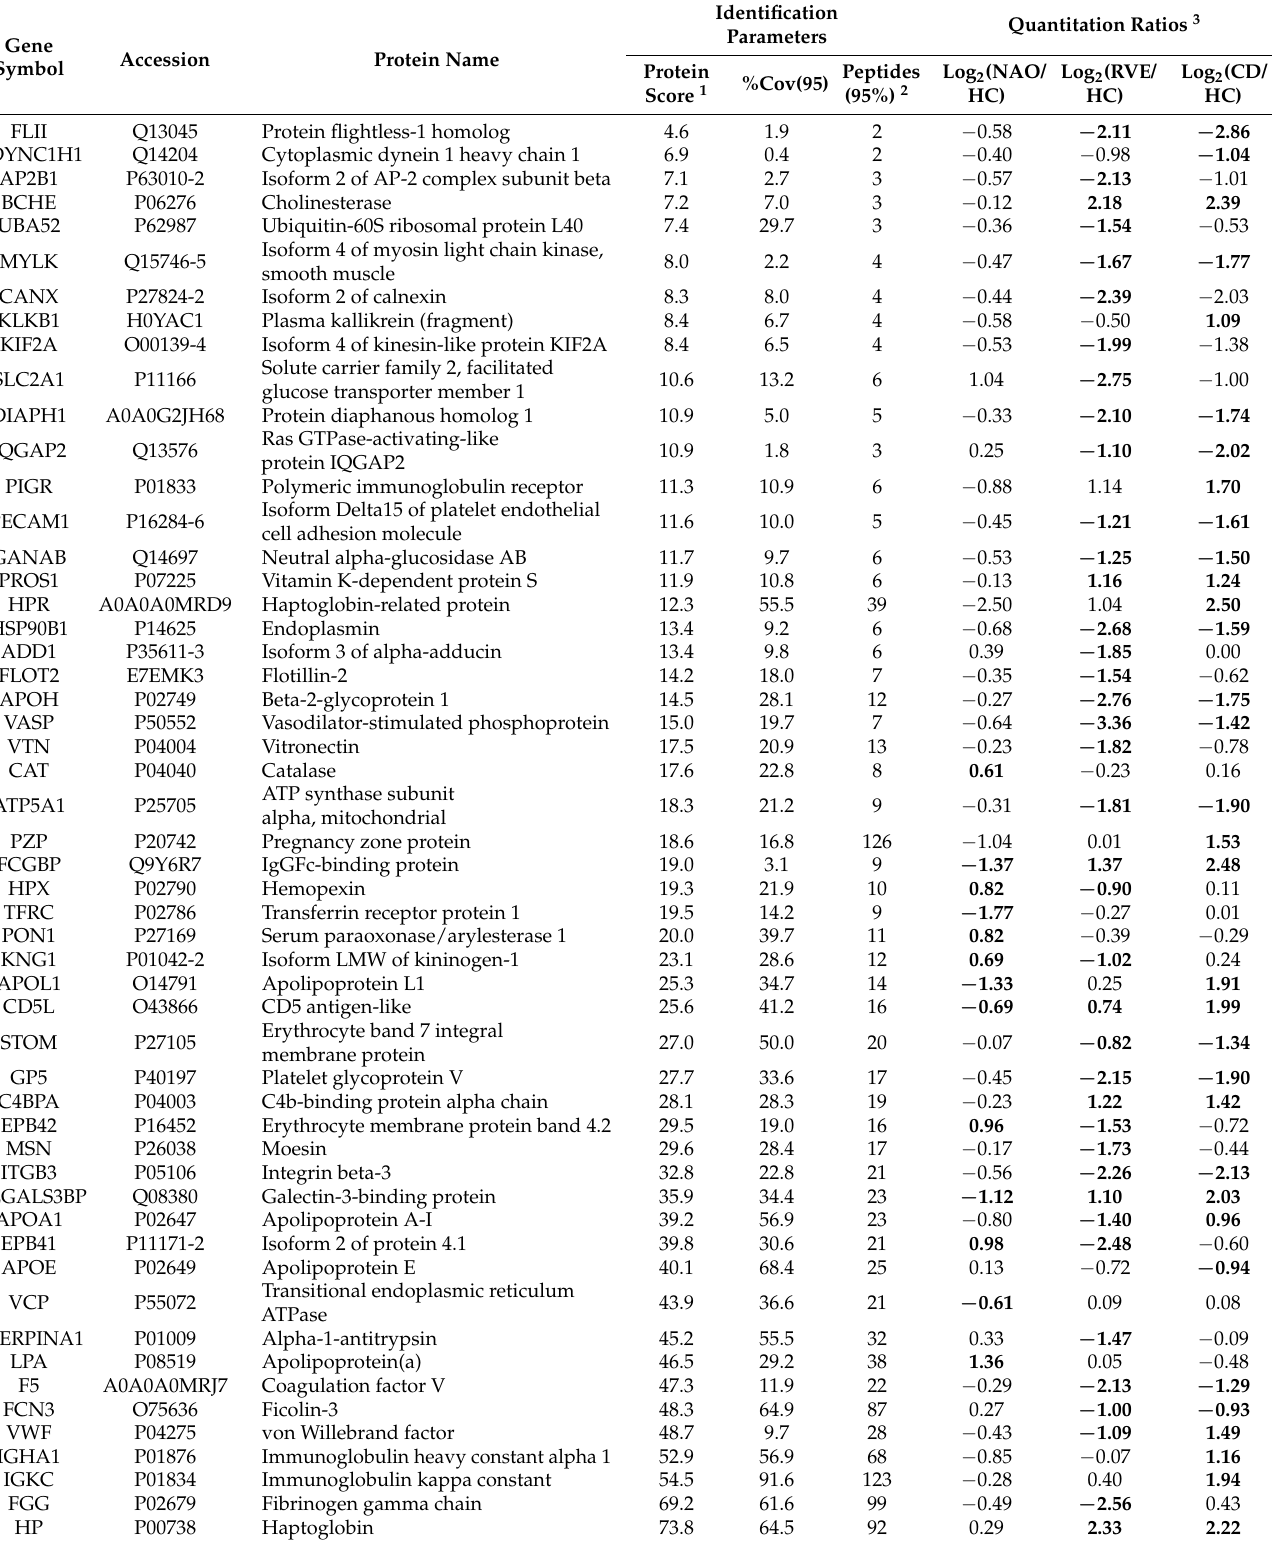
Table 1. Deregulated plasma MEV protein shortlist in LACI